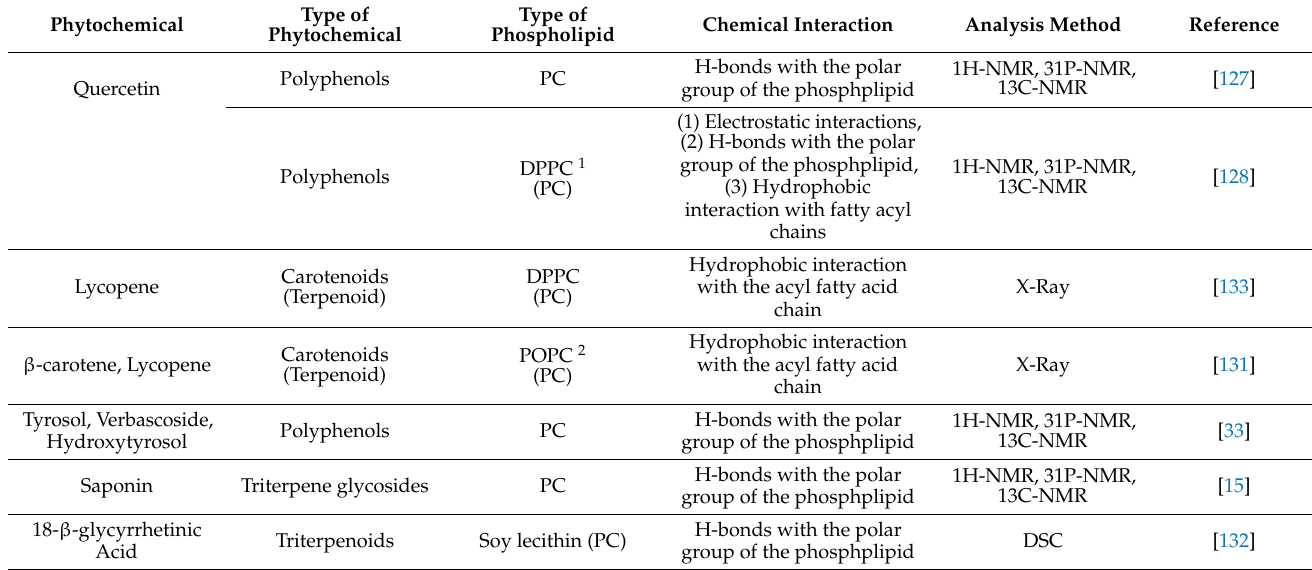
Table 4. Examples of phytochemicals-phospholipids chemical interactions during phytosomes preparation. Phytochemical Type of Phytochemical Type of